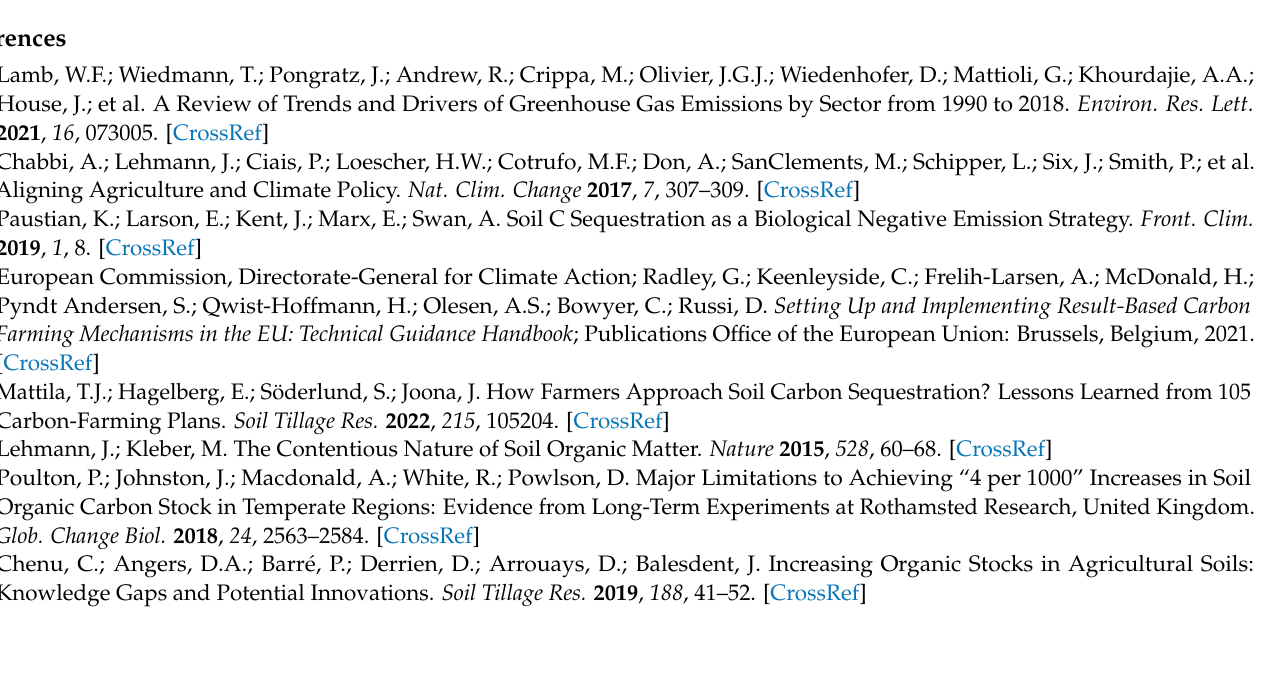
2020. Figure S3: Carbon balance in Xynisteri vines (average values in kg C per vine and standard deviation; n = 3). Berries (grapes; red color) are not included as they are removed from the system at harvest. Figure S4: Biomass C (kg C) stored annually per vine and per plant part for the three treatments (MSO, OF, SF; see par. 2.3). Figure S5: Soil (a) and root (b) respiration (kg C year − 1 ) per vine and treatment. Different letter near the boxplots means statistically significant difference. Figure S6: (a) Total biomass (in tons d.w.; grapes excluded). (b) Leaves, woody above-ground biomass, and root biomass (in tons; grapes excluded). Figure S7: Modelled and measured C for above- and below-ground biomass. MSO, OF, and SF are the three treatments. Biomass C was assumed to be equal to 50% of the d.w. of the vine parts. Table S1: Examples of mitigation actions at the farm level to manage carbon and GHG fluxes, identified to be relevant within the EU context. Adopted from [4]. Items in italics are actions linked to this research. Table S2: Soil physicochemical properties in the experimental vineyard. Average values and standard deviation (n = 6) are provided for the composite samples collected from a depth of 0–40 cm. Table S3: Physicochemical properties for the organic material. The average value and standard deviation (n = 4) are